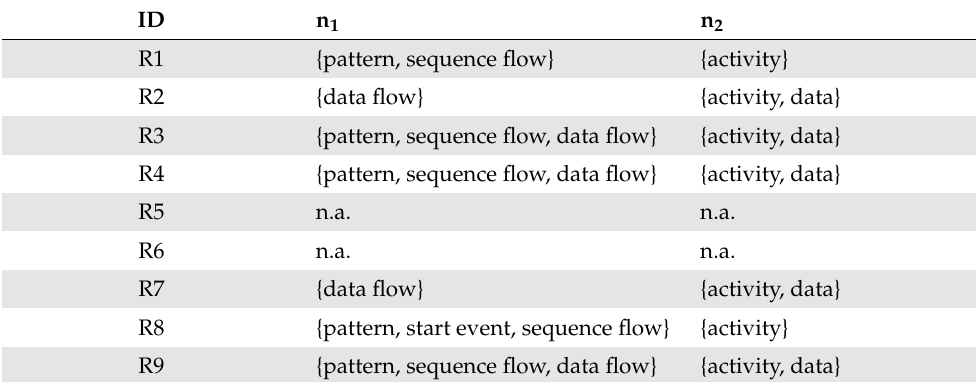
Table A1. Definitions on BPMN-Q .